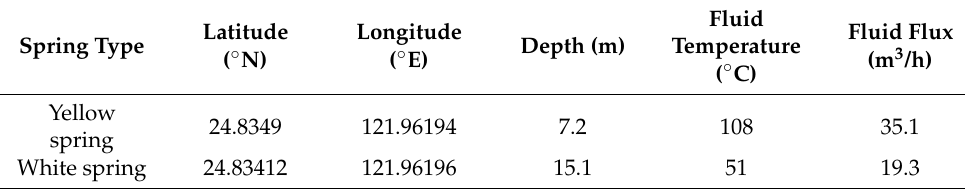
Table 1. Location of the yellow and white springs in the Kueishantao hydrothermal field as well as the fluid temperature and flux